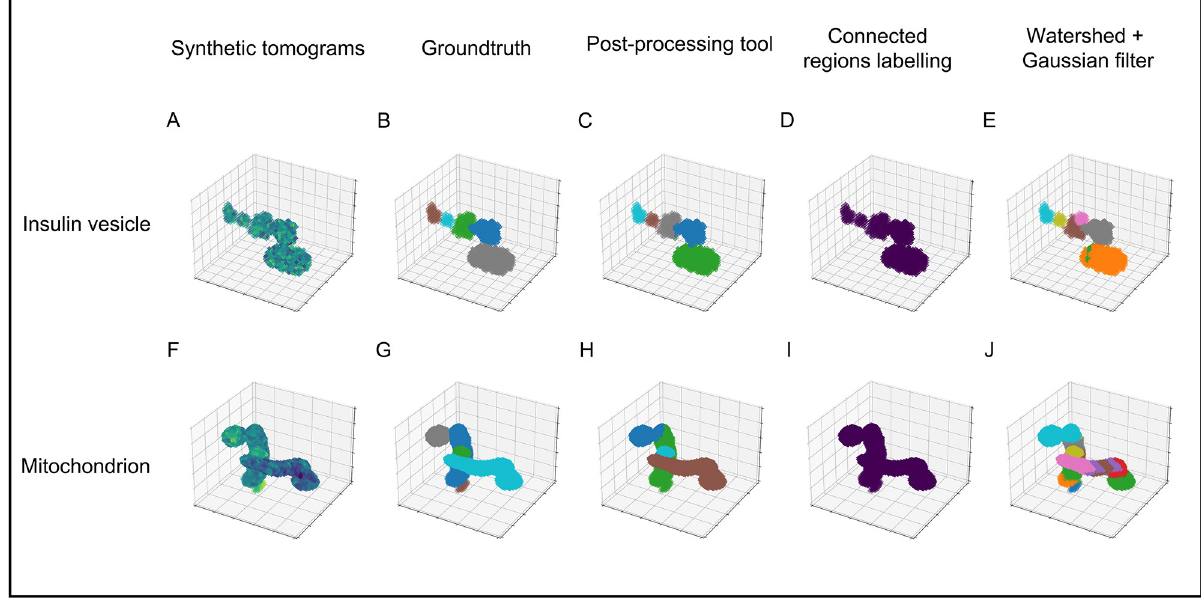
Fig 2. Separation results of mentioned methods on synthetic benchmarks. A) Synthetic tomogram of one insulin vesicle test dataset. Dark to light represents intensity from low to high. B) The groundtruth of insulin vesicle instance label, containing 5 instances. C) Results from post-processing tool, including 5 instances. D) Results from connected regions labeling method, including 1 instance. E) Results from watershed method, including 7 instances. Each color in images represents one insulin vesicle instance. F) Synthetic tomogram of one mitochondrion test dataset. Dark to light represents intensity from low to high. G) The groundtruth of mitochondria instance label, containing 5 instances. H) Results from post-processing tool, including 4 instances. I) Results from connected regions labeling method, including 1 instance. Each color in images represents one mitochondria instance. J) Results from watershed + Gaussian filter method, including 17